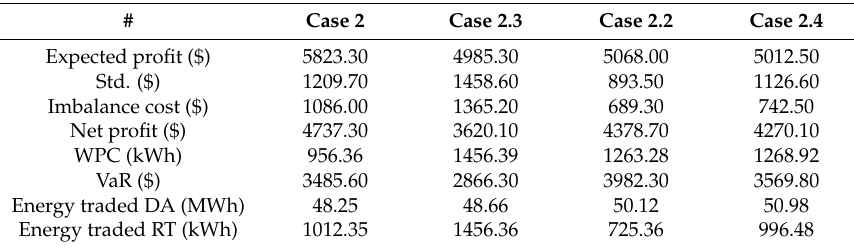
Table 4. Sensitivity analysis for integrated VPP